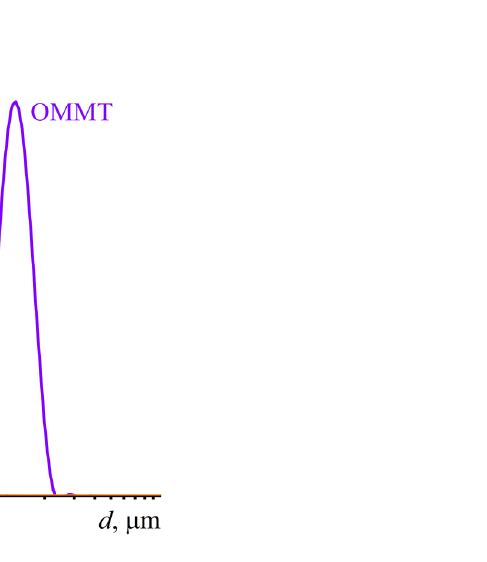
Figure 8. Size distribution of particles by scattering intensity in their 0.1% dispersion in epoxy resin.